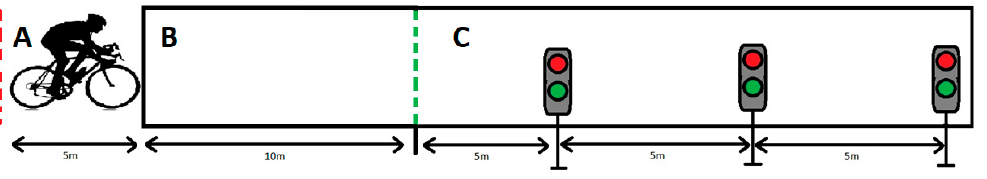
Figure 2. Spatial position of lights and areas during measurement in natural condition. A—speeding up area, B—correction velocity area, C—area with possible initiation of visual stimuli.